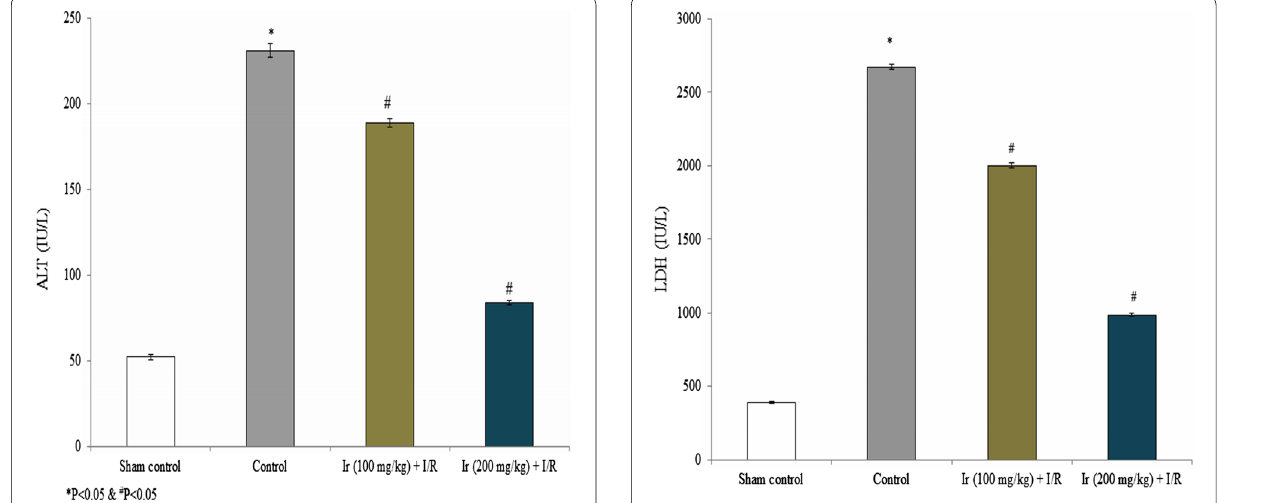
Fig. 5 Ir attenuated serum LDH enzyme level. Values are expressed IU/L. Results are shown mean with SEM.